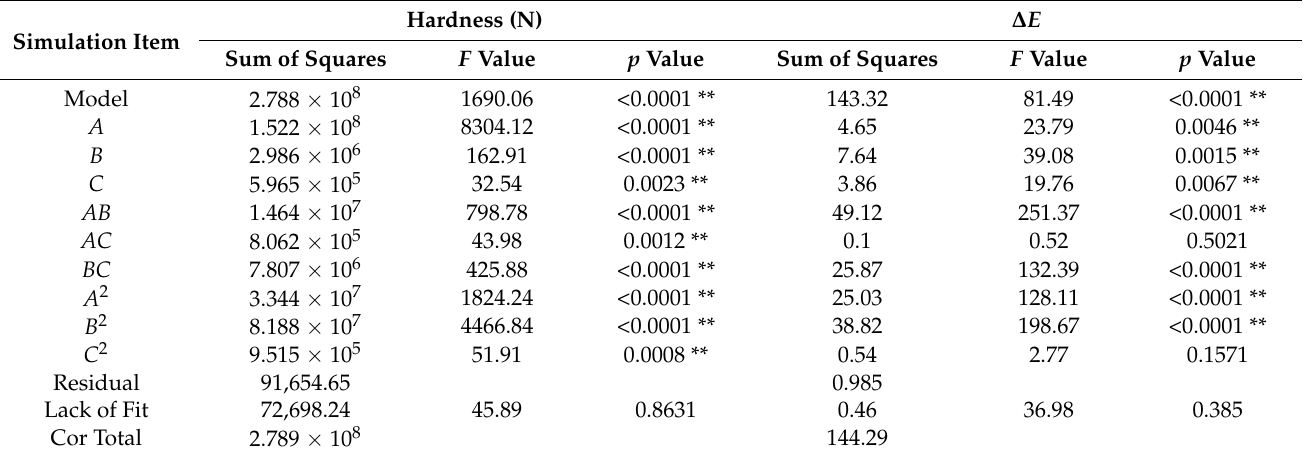
Table 3. Testing of the significance of the regression coefficients dependent